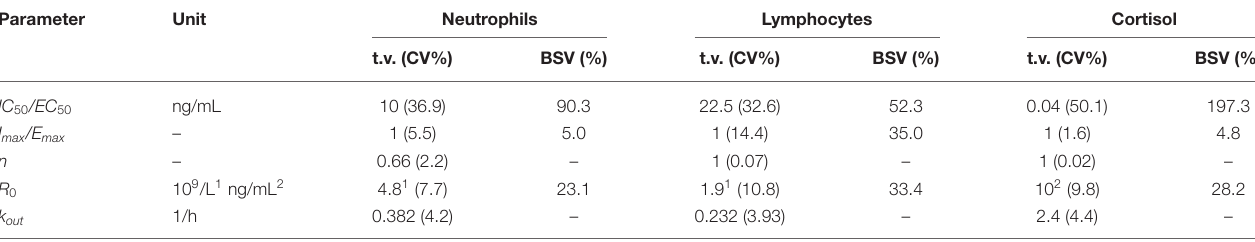
TABLE 3 | Model estimated pharmacodynamics typical values (t.v.), their corresponding relative standard deviation (CV%) and between subject variation (BSV) after intravenous administration of 1 mg/kg prednisolone succinate and ∼ 1 mg/kg prednisolone per os .